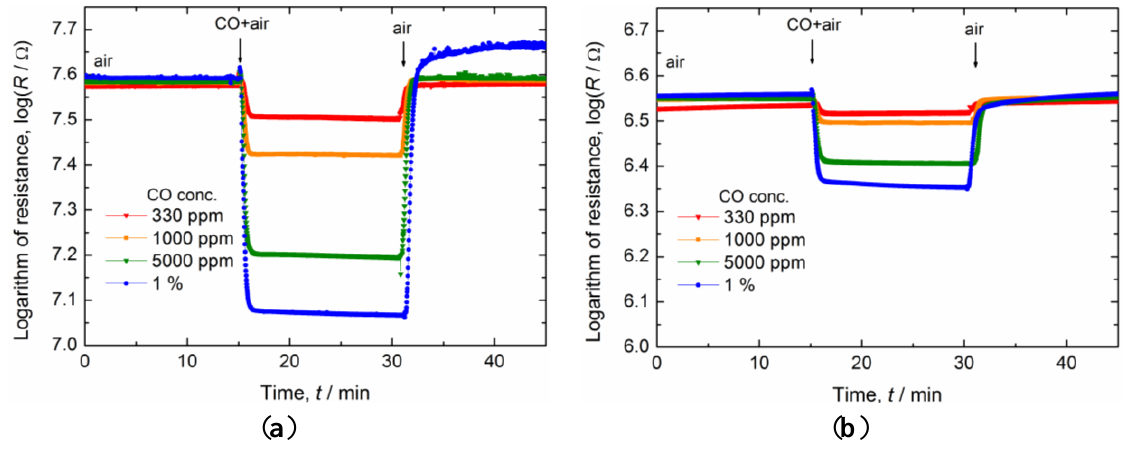
Figure 2. Change in the resistance of the sensors based on cerium oxide thick films ( a ) prepared from the core-shell nanoparticles and fired at 900 °C ( b ) prepared from the precipitated nanoparticles and fired at 950 °C. The sensors were exposed interchangeably to both air containing CO and CO-free air, with the operating temperature being 450